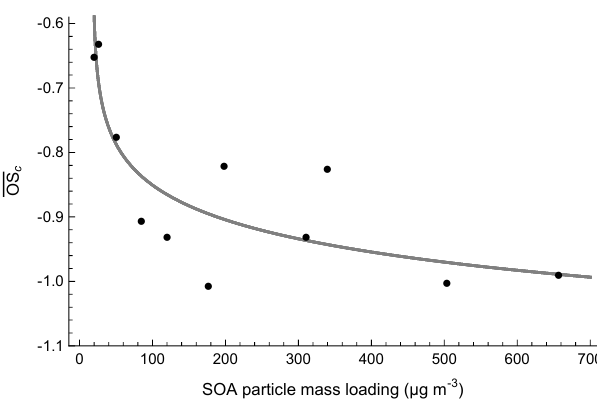
Figure 15. Average oxidation state of carbon for increasing SOA loadings generated through α -phellandrene ozonolysis experiments, with the general trend